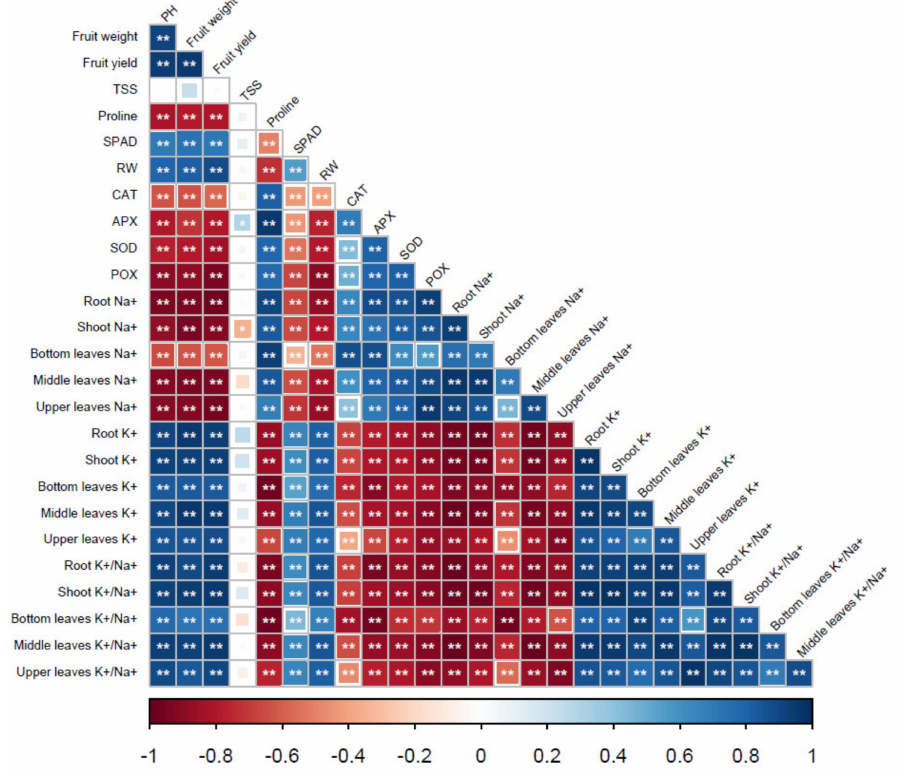
Figure 1. Association between horticultural and biochemical traits of tomato under saline